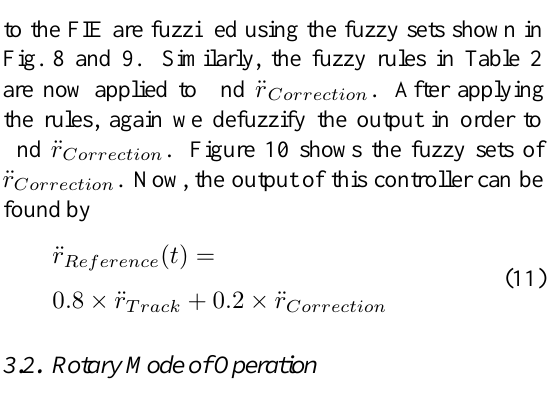
Fig. 22. Uncontrolled vs controlled out-of-plane oscillation angle θ ( t ) for the compound case using the fuzzy